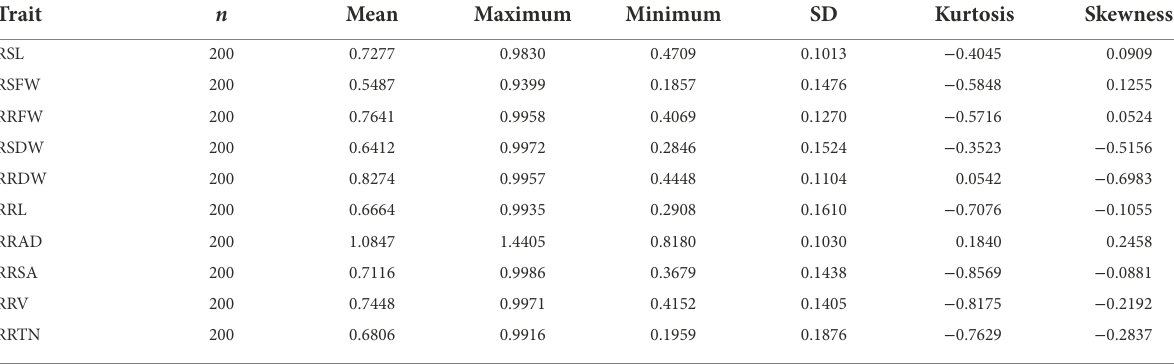
TABLE 1 Descriptive statistics of seedling stage traits under alkaline and normal conditions.